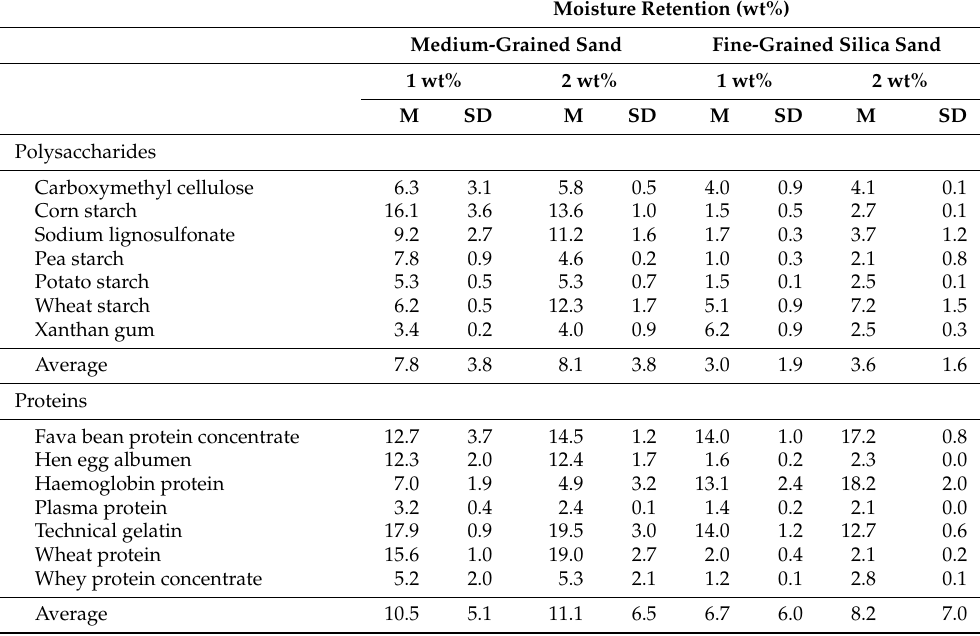
Table A2. Moisture retention of medium-grained sand and fine-grained silica sand samples treated at biopolymer concentrations of 1 and 2 wt% (XG = 0.25 and 0.50 wt%). Tests were performed in triplicates ( n = 3), with M = mean and SD = standard deviation. On medium-grained sand the water- treated control group achieved a mean moisture retention of 6.9 wt% (SD = 1.2) and on fine-grained silica sand 2.5 wt% (SD = 0.7).